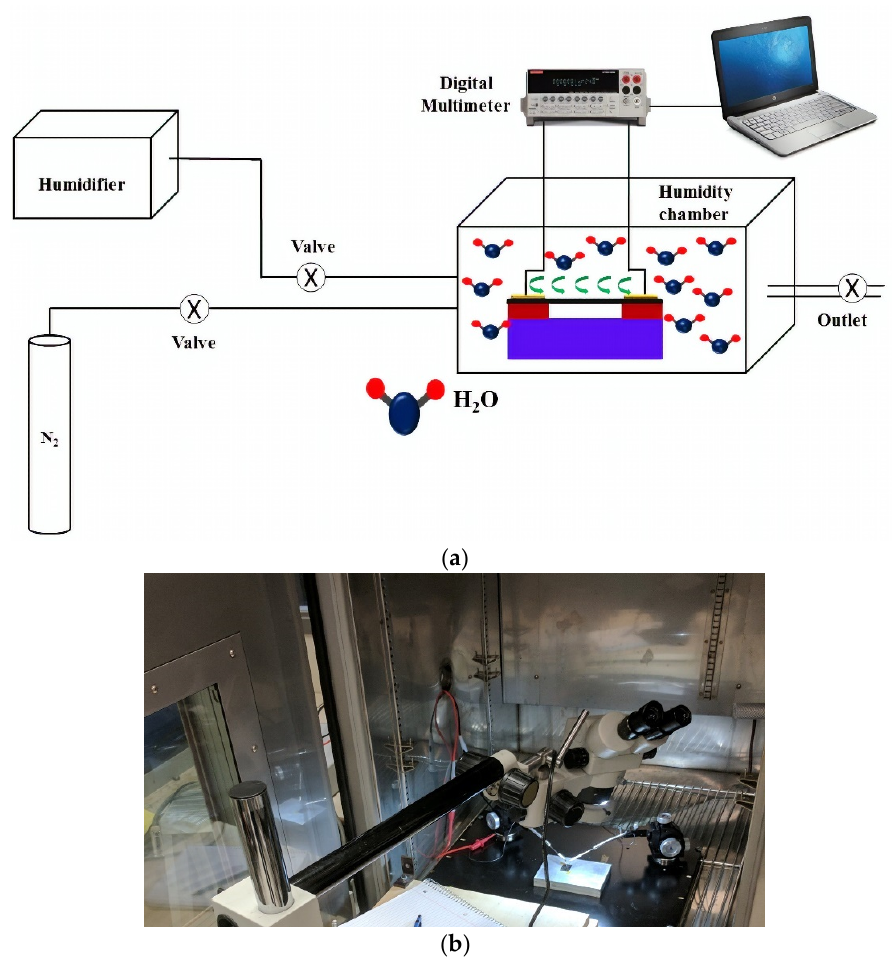
Figure 3. ( a ) Schematic of the test setup, and ( b ) Photograph of the device inside the test